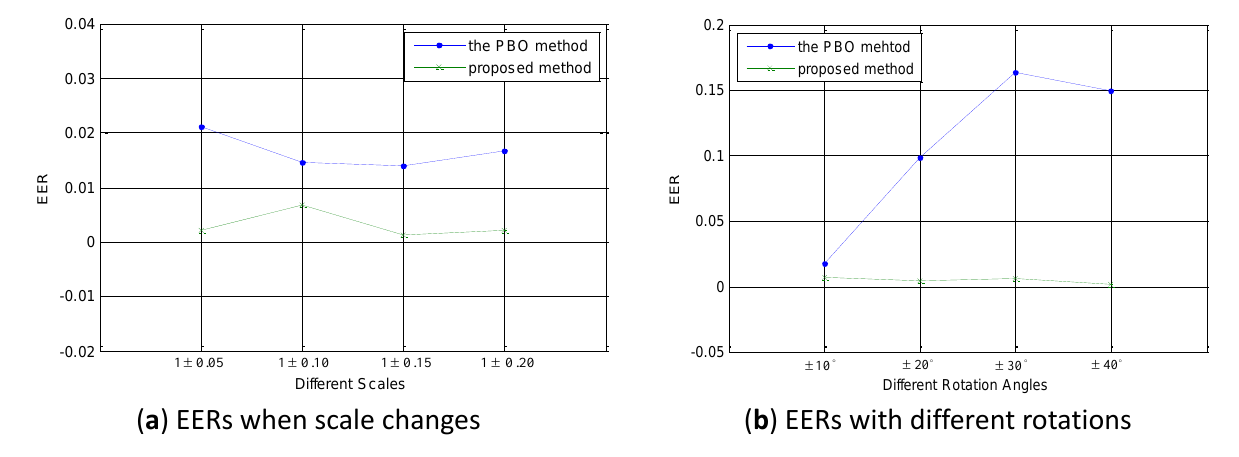
Figure 13. Performance on the secondary databases.